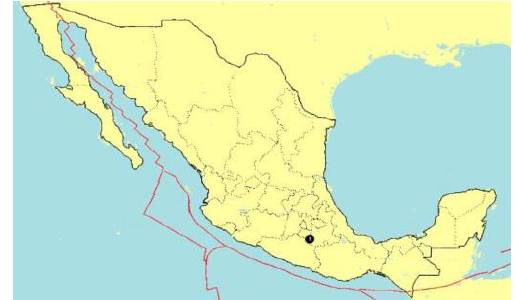
Figure 1. Epicentre of the 2017 Puebla